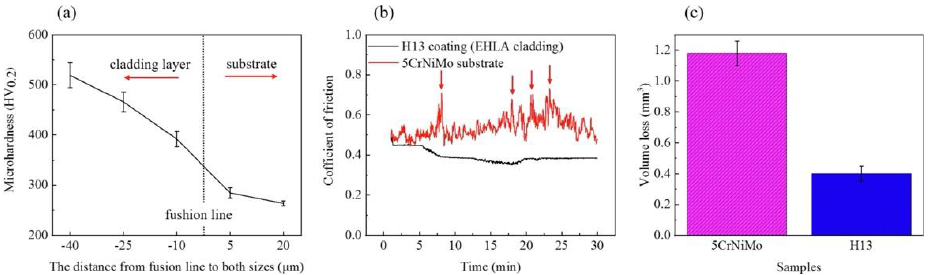
Figure 14. Variation in microhardness ( a ), COF ( b ), and volume loss ( c ) of the substrate during LC of H13 coating on the 5CrNiMo substrate. Reproduced with permission from [82]. Copyright Elsevier, 2022.